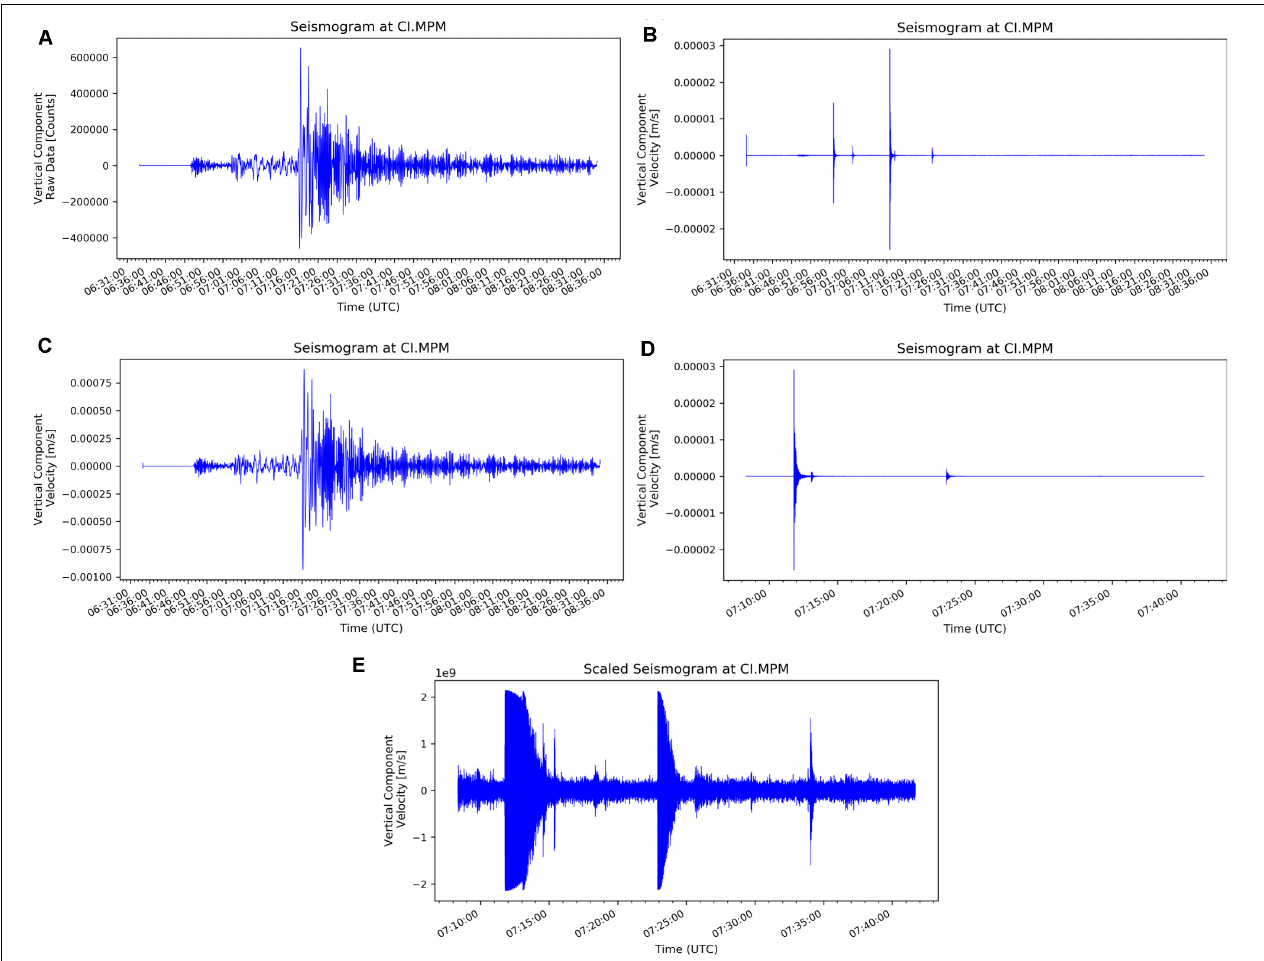
FIGURE 1 | Data processing. (A) Raw seismogram from MPM station following the February 27, 2010 Chile earthquake with M w 8.8. (B) Seismogram converted to velocity by removing the instrument response. (C) Seismogram after applying a filter from 2 to 8 Hz. (D) Seismogram is cut for the surface-wave interval. (E) Generating audio files by speeding up the time series and scaling the amplification.